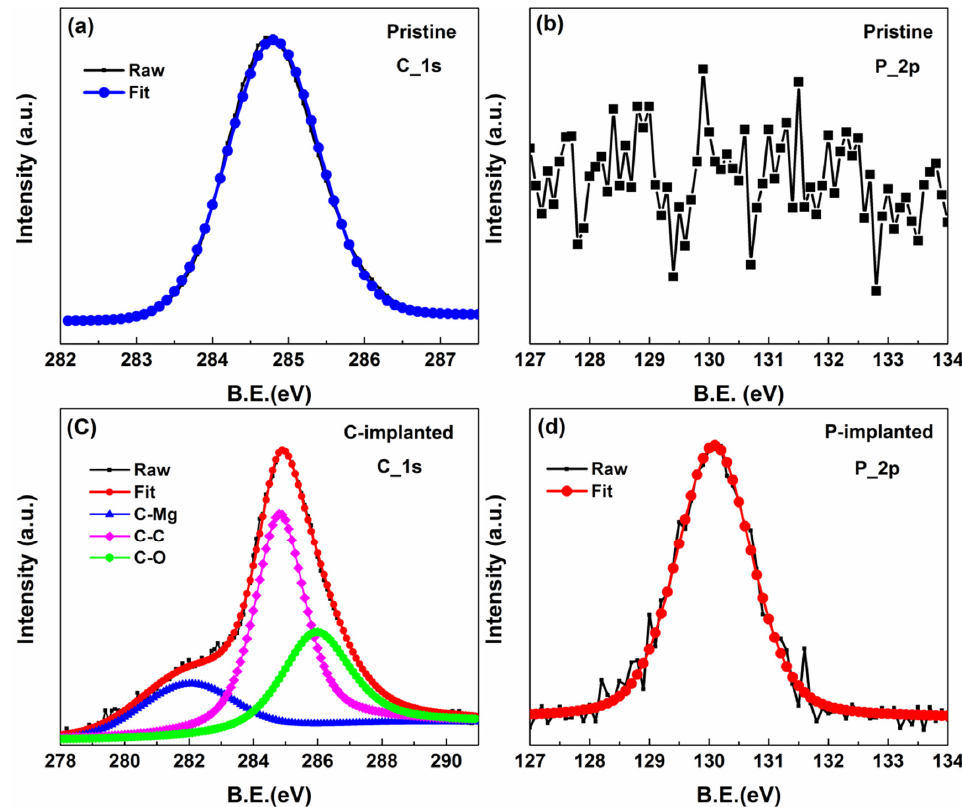
Figure 4. XPS spectra of ( a ) C 1s signal and ( b ) P 2p signal for pristine MgO sample, the black scatter-line represents the original data. ( c ) XPS spectra of C 1s signal for C-implanted MgO sample. The black scatter line represents the original XPS data. The red, blue, green, and pink scatter-lines represent the fitted bonding states. ( d ) XPS spectra of P-2p signal for P-implanted MgO sample, the black and red scatter-lines represent the original XPS data and fitted data.